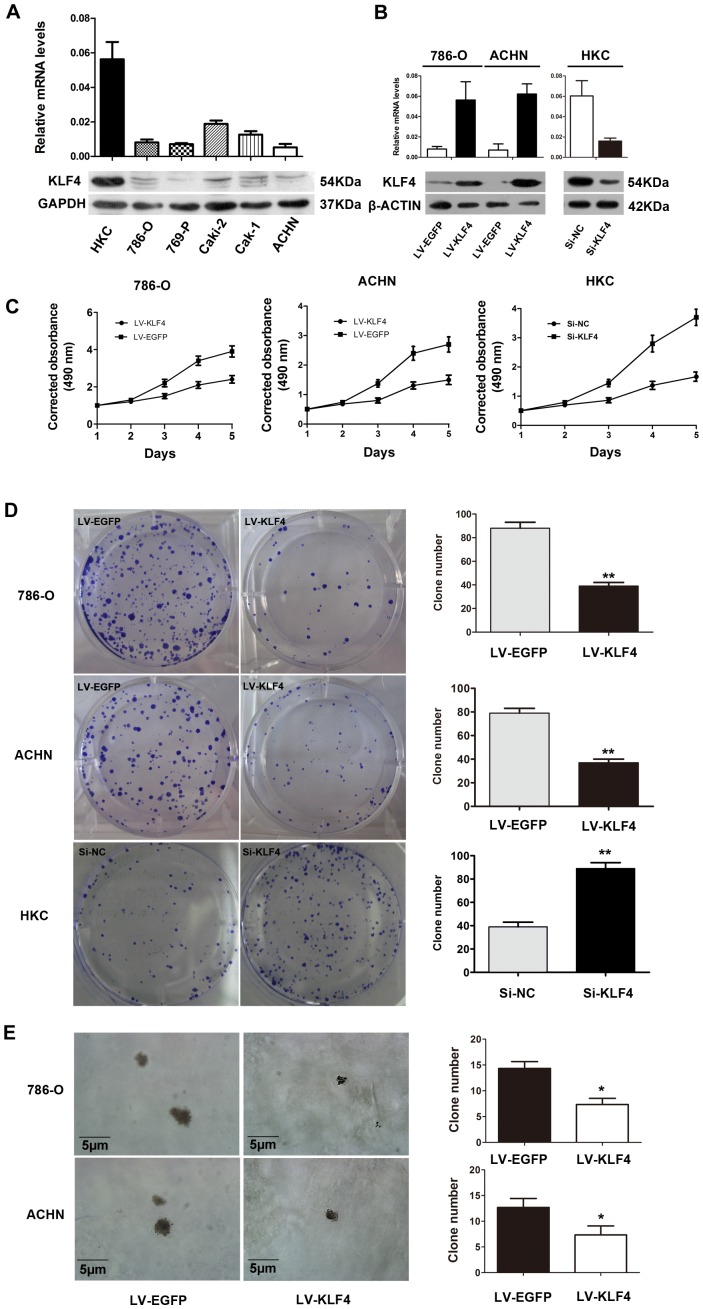
KLF4 was absent and inhibited the proliferation in ccRCC cell lines.(A) KLF4 expression in normal renal proximal tubular epithelial cell line HKC and ccRCC cell lines. KLF4 expression was reduced in the five ccRCC cell lines compared with the HKC cells. Top: KLF4 RNA downregulation in ccRCC cell lines, in which PPIA was used as a control sample. Bottom: KLF4 protein downregulation in ccRCC cell lines, in which GAPDH was used as a control sample. (B) KLF4 expression after 786-O and ACHN cells were infected with LV-EGFP or LV-KLF4 for 96 h. Real-time PCR and western blot analyses were performed to confirm the infection efficiency. The expression levels of KLF4 in HKC cells was also determined after KLF4 knockdown. PPIA and β-actin were used separately as the control treatments. (C) MTS assay revealed the decreased proliferation in 786-O and ACHN cell after KLF4 was overexpressed, the converse effect was also shown after KLF4 knockdown in HKC cells. The data shown are means from two independent experiments and each experiment was performed in triplicate. (D) Induced KLF4 expression significantly inhibited the growth of 786-O and ACHN cells. A opposite effect was observed after KLF4 knowkdown in HKC cells. Left panel: Representative anchorage-dependent growth assay of 786-O, ACHN and HKC cells. Right panel: Quantitative analyses of the colony numbers are shown as mean±SD. The efficiency of anchorage-dependent growth was significantly inhibited (**P<0.01) in KLF4-overexpressed cells compared with that in blank vector-transformed control group in 786-O and ACHN cells, promoted cell growth can be observed after KLF4 knockdown in HKC cells. (E) KLF4 overexpression significantly inhibited the anchorage-independent growth ability in 786-O and ACHN cell lines compared with the control treatment. Left panel: Photomicrographs of the representative fields in which the cells with induced KLF4 expression (LV-KLF4) formed fewer and smaller colonies in the soft agar than those in the vector-transfected (LV-EGFP) cells in 786-O and ACHN cells. Right panel: Quantitative analyses of the colony numbers are shown as mean±SD, *P<0.05 versus the LV-EGFP.